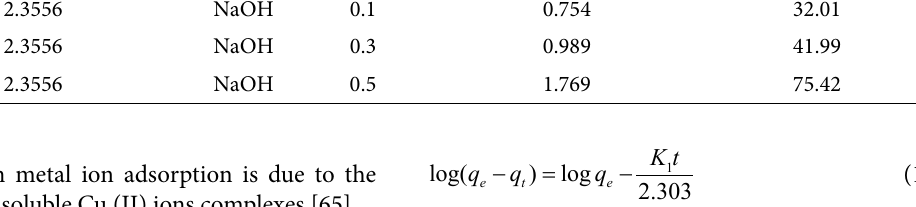
Adsorbet adsorbed by adsorbent at saturated point (mg g -1